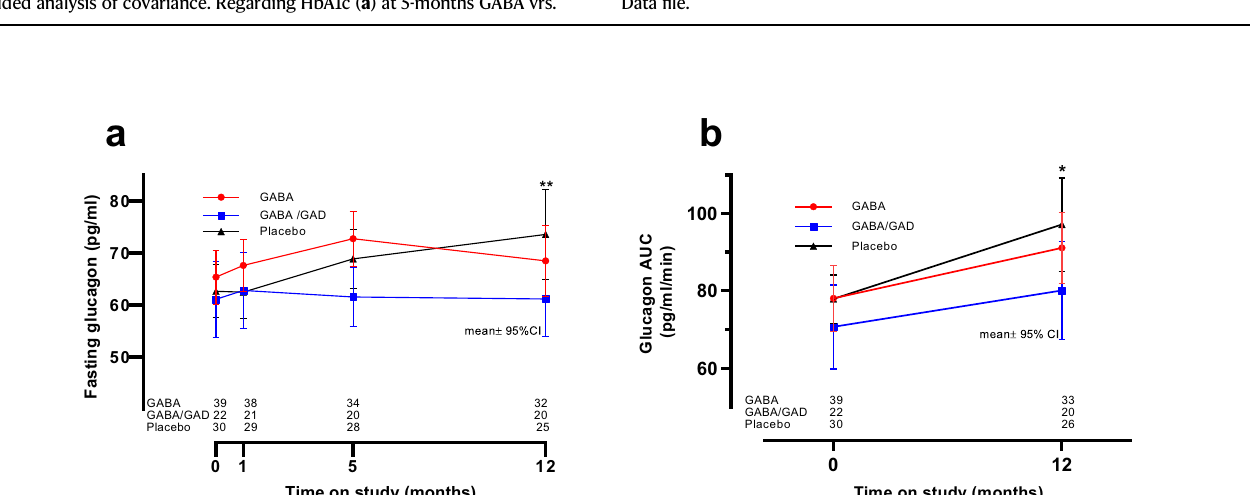
Placebo ** p =0.003 and GABA vrs GABA/GAD * p =0.041. For IDAA1c ( b ) at 5- months,GABAvrs.Placebo** p =0.007andGABAvrs.GABA/GAD** p =0.002.At12- months, GABA vrs. Placebo * p =0.020. Source data are provided as a Source Data fi le.